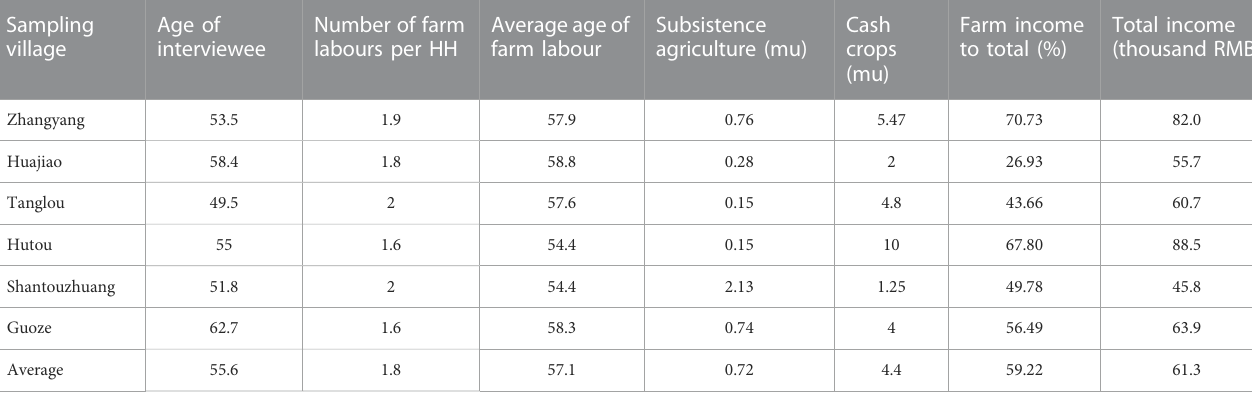
TABLE 2 Descriptions of sampled rural